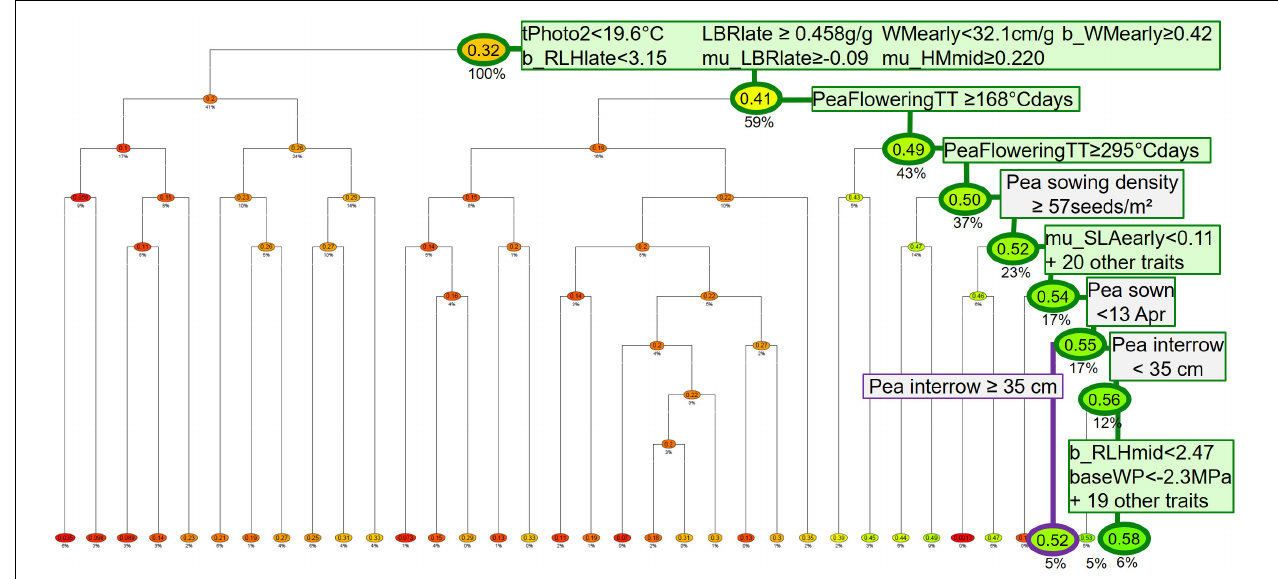
FIGURE 2 | Example of regression and classification tree (CART) analyzing potential yield of spring pea from weed-free simulations (response variable) as a function of pea parameters (in green), pea management techniques, and other-crop techniques (in gray) (predictors). Only pea crops with herbicides were used here. The highlighted branches show the best and third-best performances (which are also shown in Table 5A ). Boxes show principal and surrogate predictors and thresholds for splitting branches (only for the two highlighted branches). Leaves (at the bottom of the tree) and nodes show indicator values normed to [0 = lowest yield, 1 = highest yield of simulated data set]; leaves are colored from red (lowest yield) through yellow (intermeidate yield) to green (highest yield). Percentages below nodes show the proportion of individuals that fall into that node. The root node at the top of the tree has 100% since the dataset has not been split yet